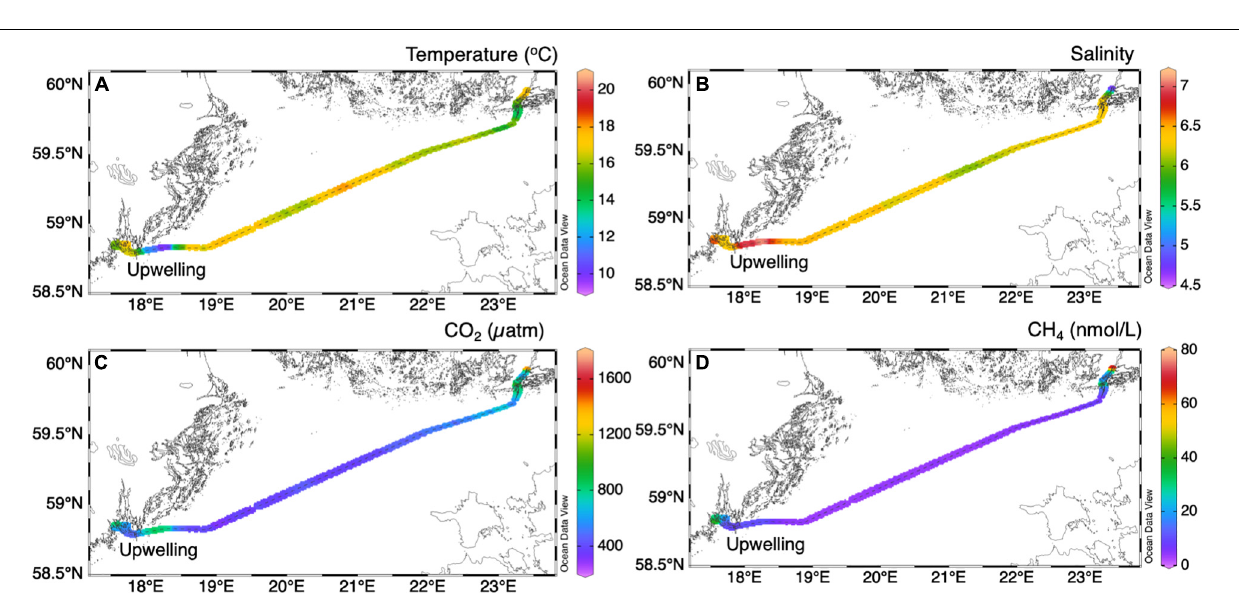
Frontiers in Marine Science |